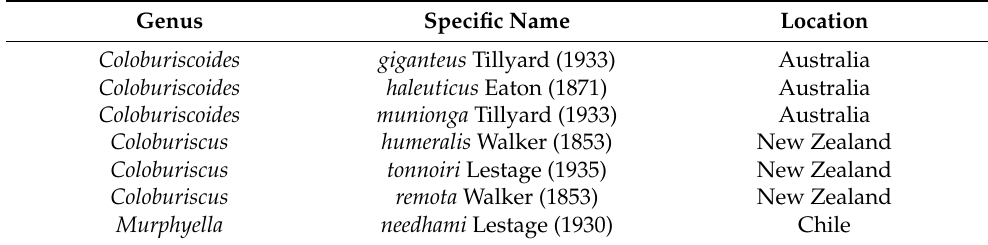
Table 1. The location of each taxon of Coloburiscidae.